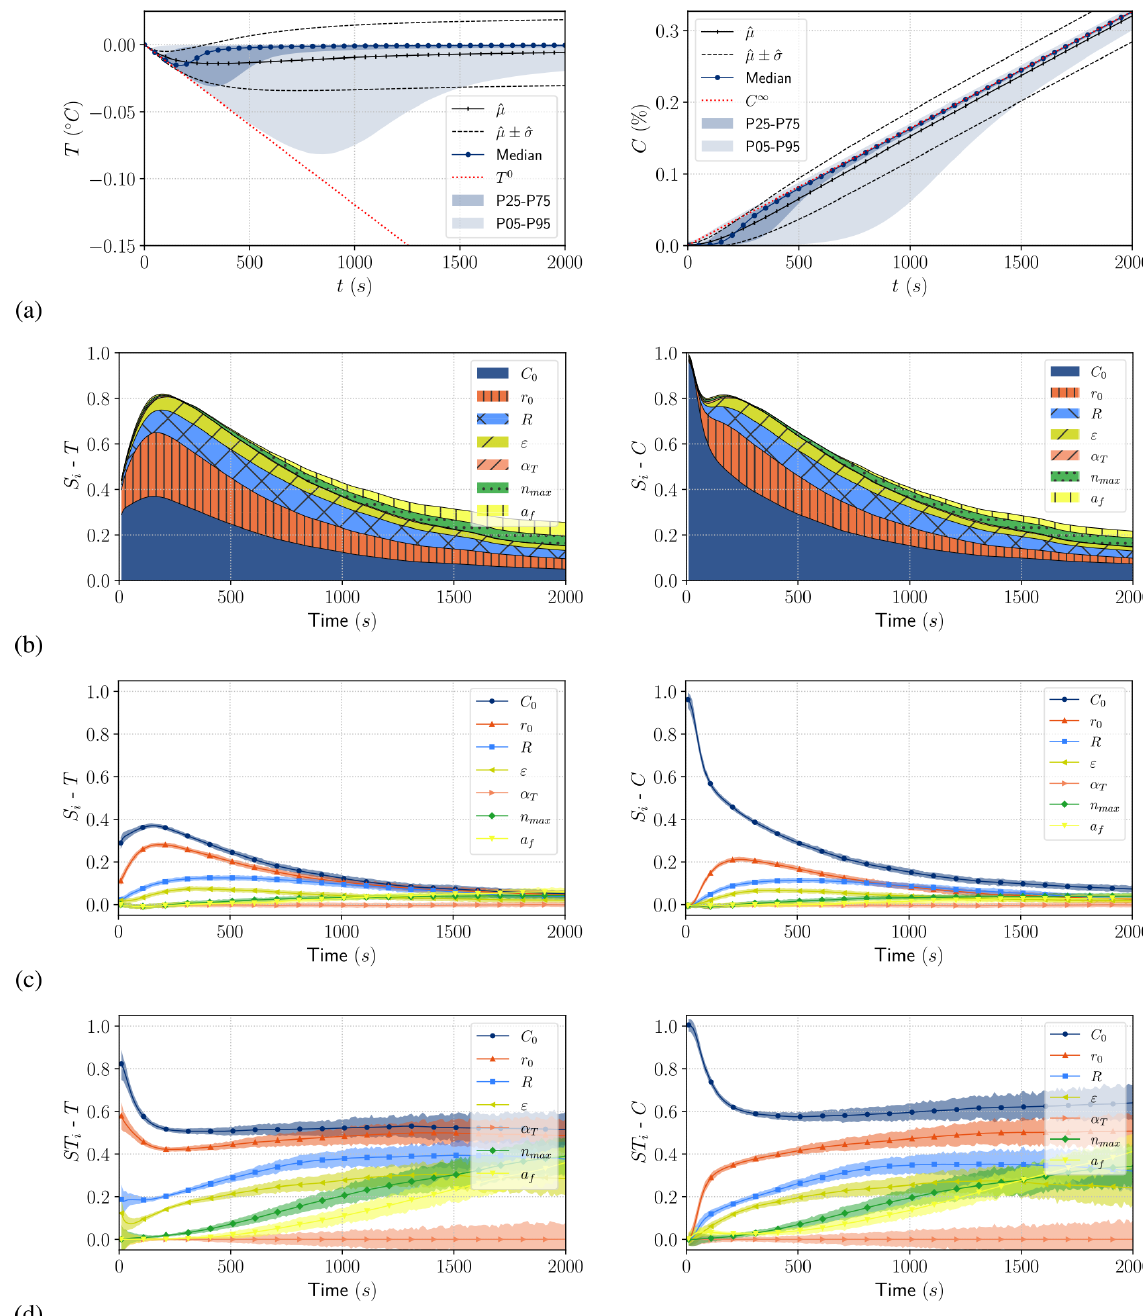
Figure G1. Results of case 2. From top to bottom: uncertainty propagation result (a) , first-order Sobol indices (b) , first-order Sobol indices with 95% confidence intervals (c) , and total-order Sobol indices with 95% confidence intervals (d) for temperature (left panels) and frazil (right